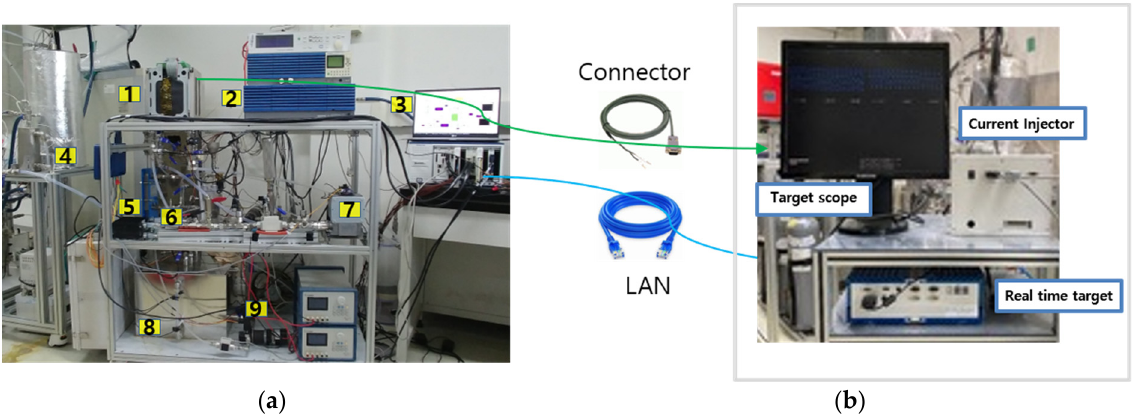
Figure 10. Photos of experiment setup with fuel cell system by on-line EIS (1: fuel cell stack, 2: load, 3: monitoring system, 4: reformer, 5: humidifier, 6: heat exchanger, 7: air blower, 8: water tank, 9: water pump). ( a ) 1 kW fuel cell system. ( b ) On-line EIS.